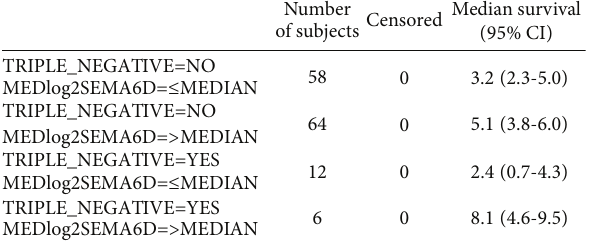
Figure 6: Interaction of SEMA6D with TNBC in patients’